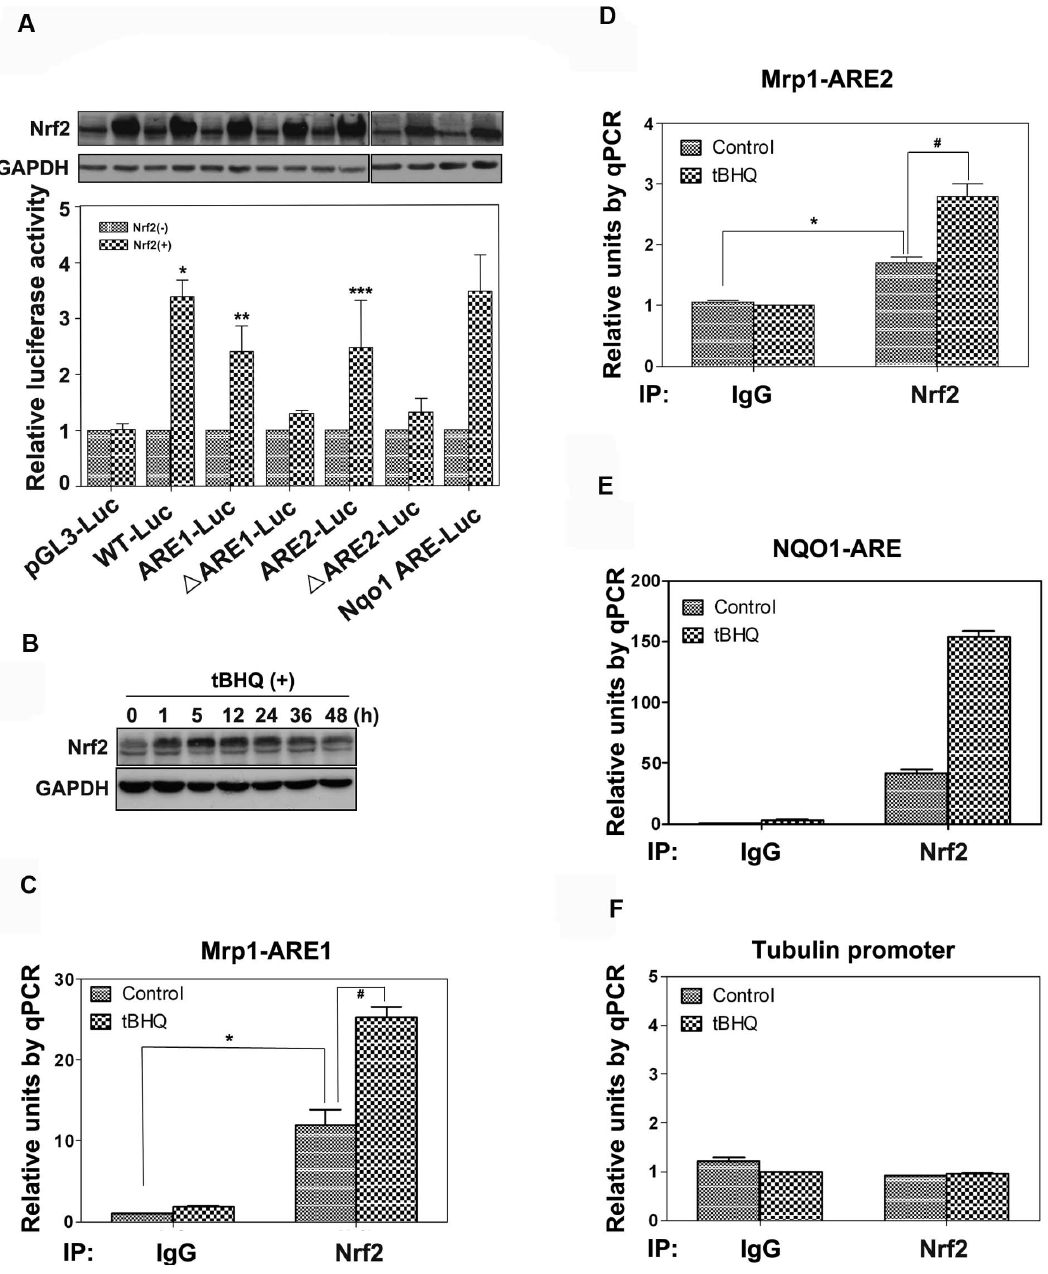
Figure 4. Nrf2-mediated induction of Mrp1 promoter activity depends both on ARE1 and ARE2 in 231 cells. (A) 231 cells were transfected with five luciferase reporter constructs (wt-Luc, ARE1-Luc, ARE2-Luc, D ARE1-Luc and D ARE2-Luc), and promoterless pGL3-basic (pGL3- Luc), NQO1-ARE-Luc and pRL-TK were used as negative control, positive control and internal control, respectively. The aforementioned plasmids were co-transfected with or without Nrf2-expression plasmid. After 48 hours, cells were harvested and luciferase activities were measured with a dual- luciferase assay system (lower panel). Data were means 6 SD of values from three independent experiments. The equal amount of transfection of Nrf2 was assured by western Blot (upper panel). (B) 231 cells were treated with 40 m M tBHQ for the indicated time point, and then were harvested to be subjected to immune blot to measure Nrf2 protein level. Experiments were performed three times and a representative immunoblot was shown here. (C), (D), (E) and (F) 231 cells were treated or not with 40 m M tBHQ for 24 h and were cross-linked with formaldehyde. Sonicated chromatin was subjected to immunoprecipitation with antibodies against Nrf2 or normal IgG. Precipitated DNA was followed by realtime PCR analysis with primers against Mrp1 ARE1 (panel C), Mrp1 ARE2 (panel D), NQO1 ARE (panel E) and Tubulin promoter (panel F). Experiments were performed three times